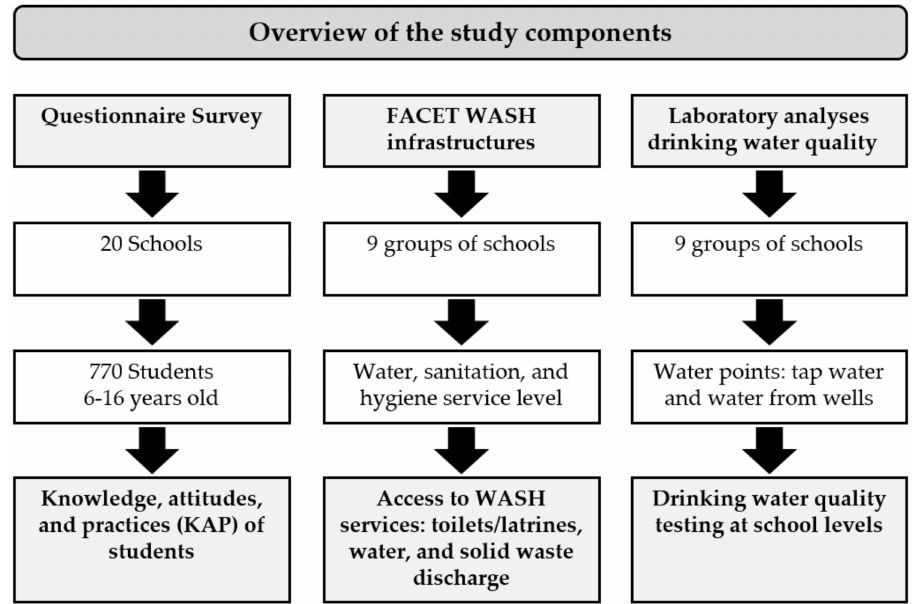
Figure 2. Research framework, showing the study method